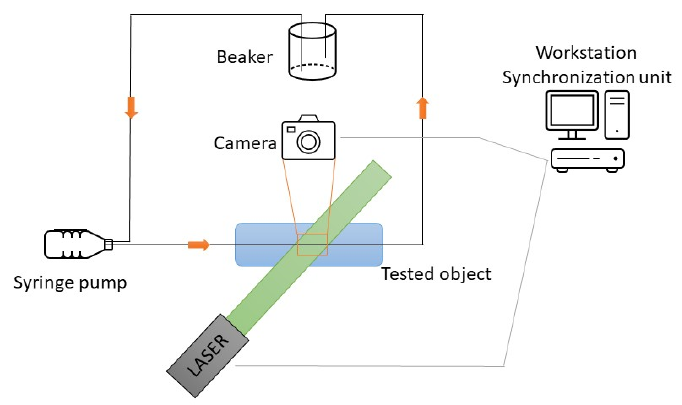
Figure 3. The main components of the research setup.